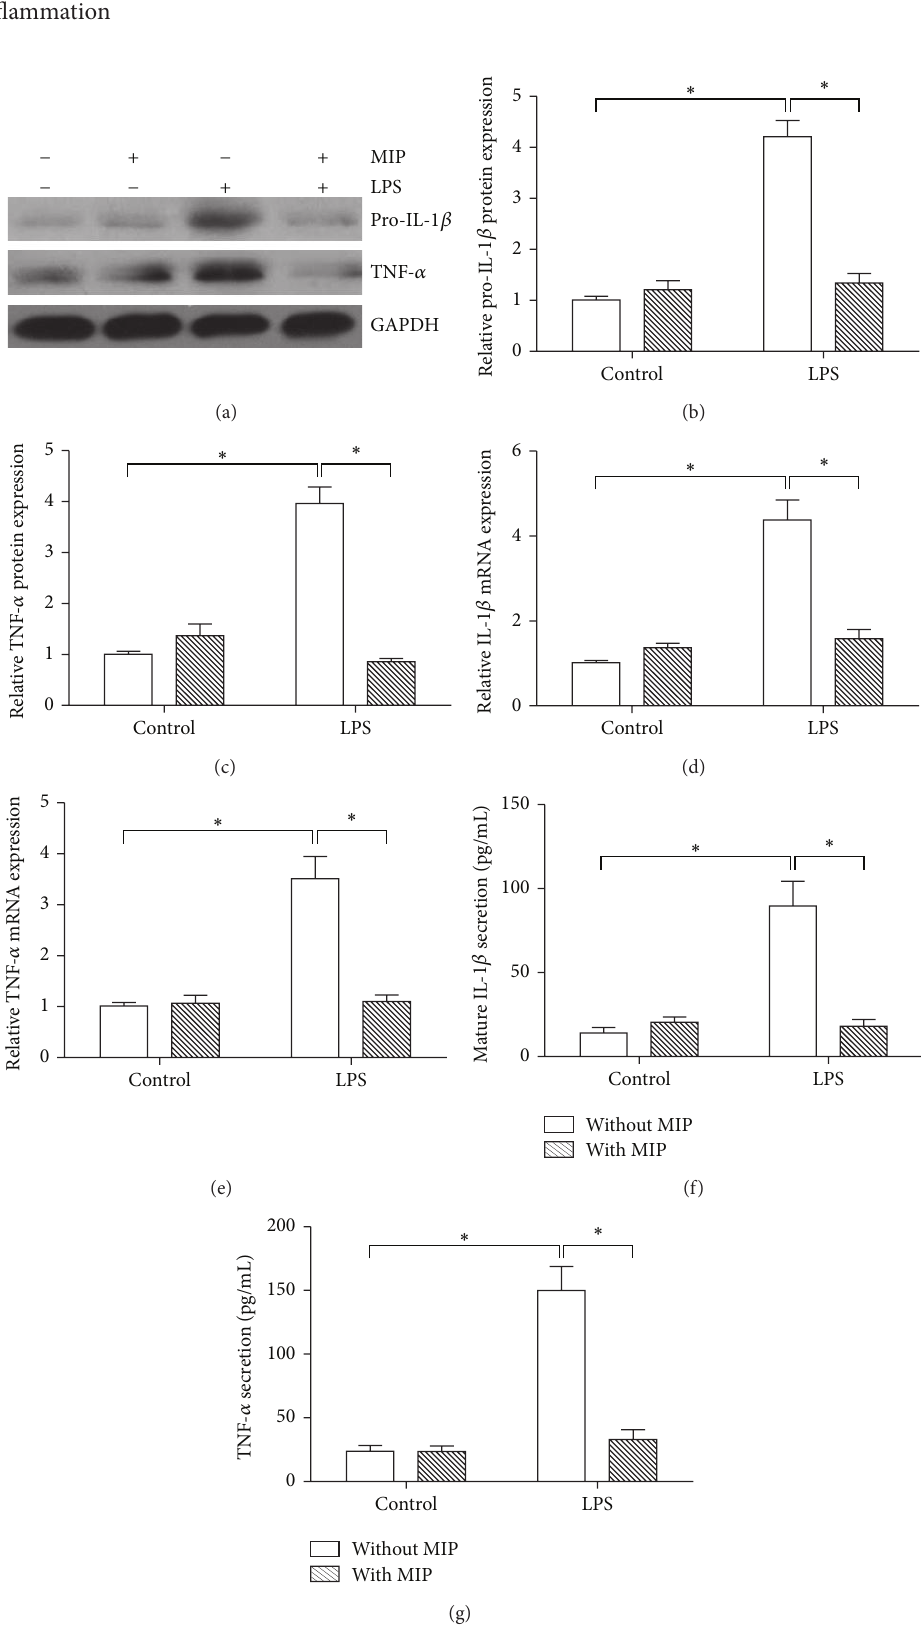
Figure 6: Effect of MyD88 on the expression of IL-1 𝛽 and TNF- 𝛼 in SFs. SFs were pre-treatment with or without MIP, then stimulated with LPS. Cell lysates were collected (at 12 h) for analyzing the protein expression by Western blot (a), and the relative expression of pro-IL-1 𝛽 (b) and TNF- 𝛼 (c) was calculated. Total RNAs were extracted (at 6 h) for detecting mRNAs of IL-1 𝛽 (d) and TNF- 𝛼 (e) by real-time quantitative PCR. The cell-free culture medium from each sample was collected at 12 h, and the mature IL-1 𝛽 (f) and TNF- 𝛼 (g) proteins secreted into the cell culture media were measured by ELISA. Data shows all the values from independent samples of 𝑛 = 3 , ∗ 𝑃 < 0.05 versus nonstimulated controls or cells without MIP